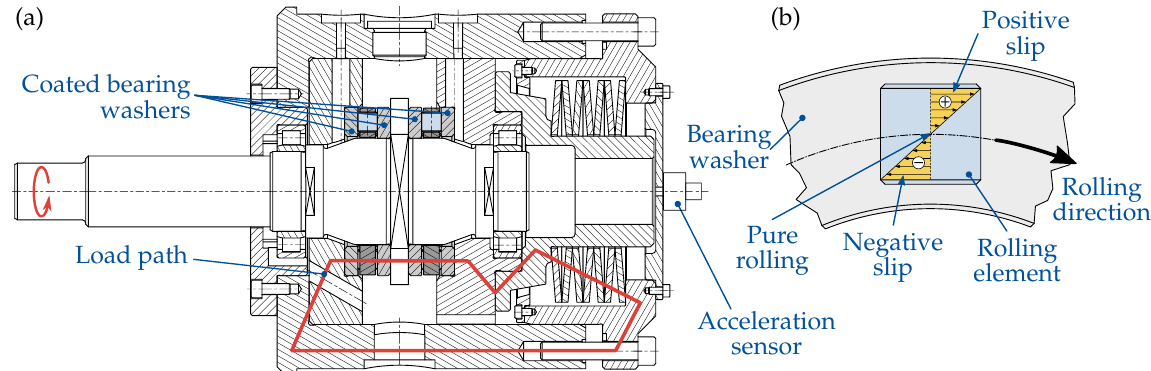
Figure 2. Schematic representation of the test rig and the tribological system: ( a ) FE8 test head with type 81212 cylindrical roller thrust bearing. ( b ) Slip distribution in axial cylindrical roller thrust bearings displayed on the bearing washer.